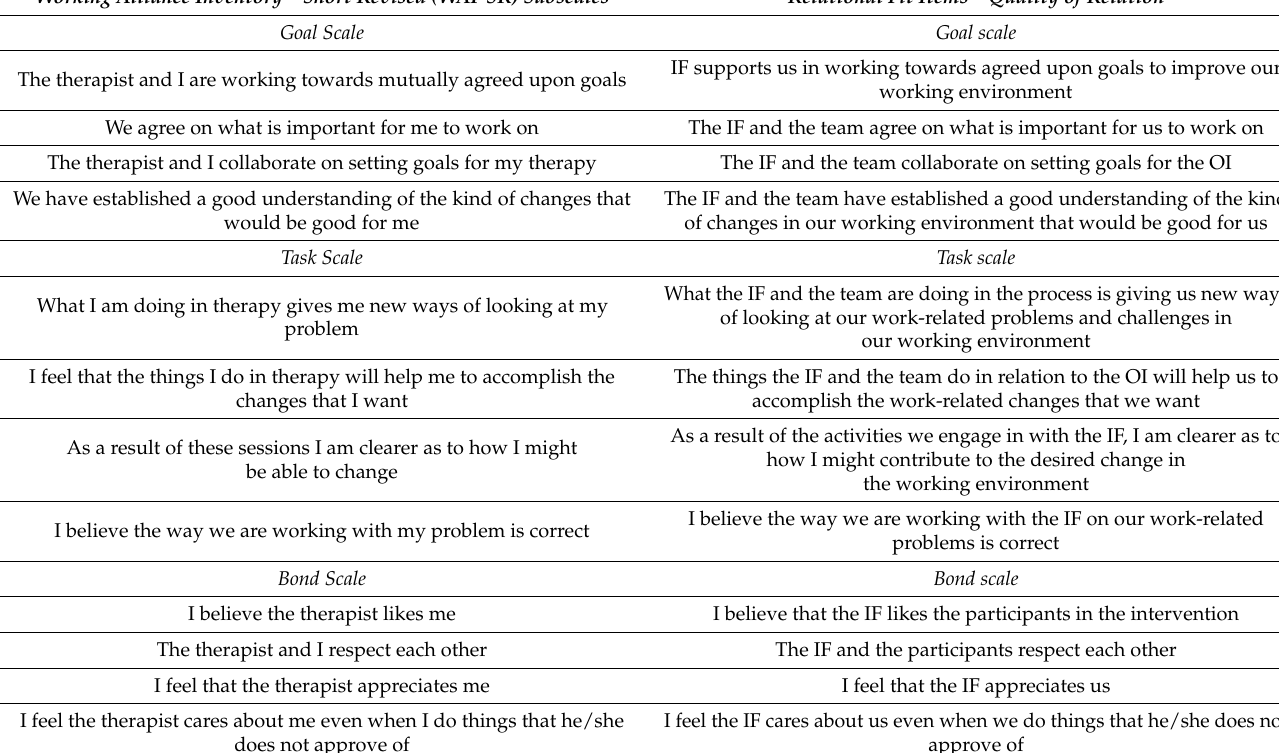
Table 3. (Re)conceptualization of the WAI-SR into relational fit: Quality of